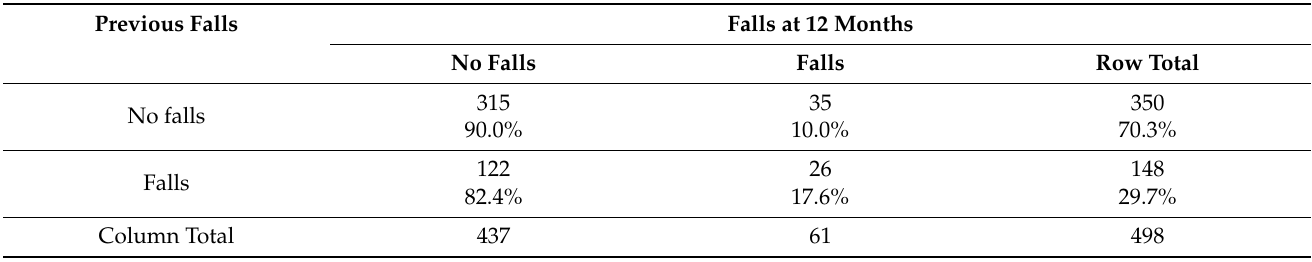
Table 2. Difference in falls at 12 months in relation to the existence of previous falls *.